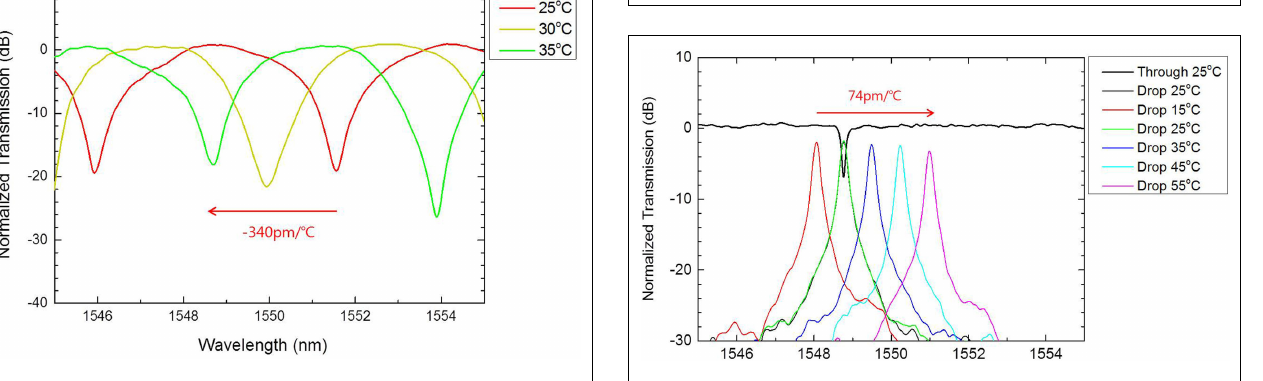
FIGURE 4 | Normalized transmission spectra of MZI with titania cladding as the temperature varied from 25 to 35°C when L = 360 μ m, w1 = 1350nm, and w2 = 350nm .